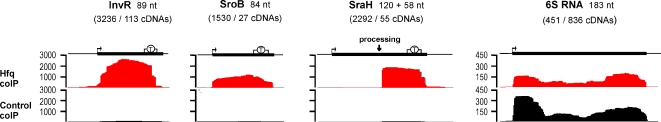
Visualization of the clone distribution of exemplar Hfq dependent and independent sRNAs in Salmonella.
Clone distribution for sequences mapped to InvR, SroB, SraH, or 6S sRNAs (red: Hfq coIP, black: control coIP). The vertical axis indicates the number of cDNA sequences that were obtained. A bent arrow indicates each sRNA promoter, a circled “T” its transcriptional terminator.